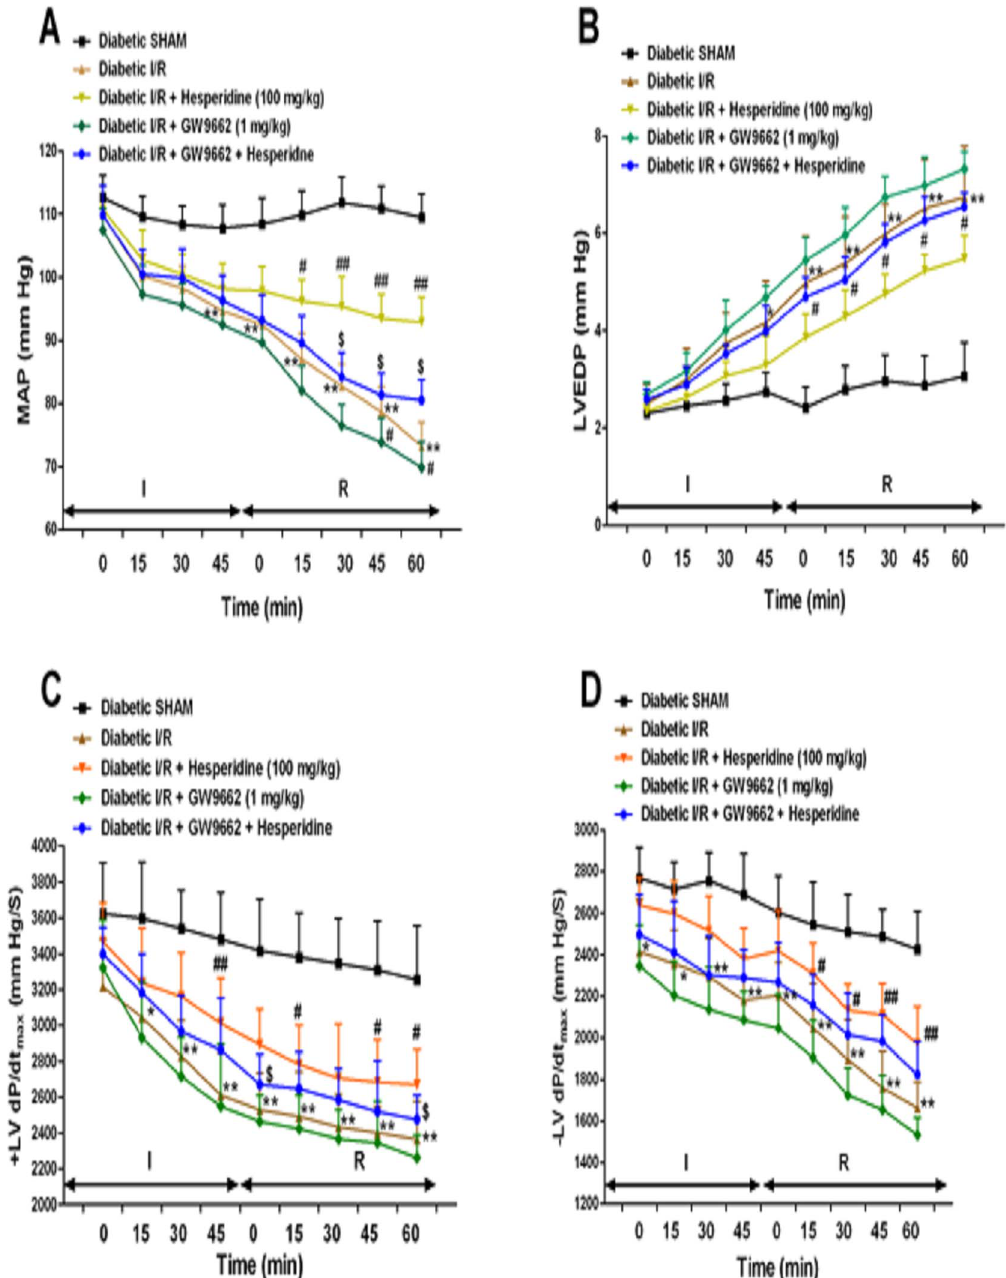
Figure 2. Effect of hesperidin and GW9662 on mean arterial pressure (MAP) and left ventricular (LV) function following ischaemia/ reperfusion (I/R) in diabetic rats. (A) MAP, (B) left ventricular end-diastolic pressure (LVEDP), (C) maximal positive rate of left ventricular pressure ( + LVdP/dtmax) and (D) maximal negative rate of 2 LVdP/dtmax. Data are expressed as the mean 6 standard error (n=22/group). Significance was determined by repeated measures analysis of variance followed by the Bonferroni’s post hoc test: *p , 0.05, **p , 0.001 vs Diabetic SHAM; # p , 0.05, ## p , 0.001 vs Diabetic I/R; $p , 0.01 vs respective Hesperidin.